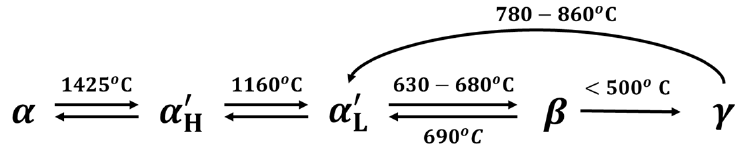
Table 1. Structural information and parameters for the prototype 8B2 and C23 prototype structures and the five polymorphs of belite (Ca 2 SiO 4